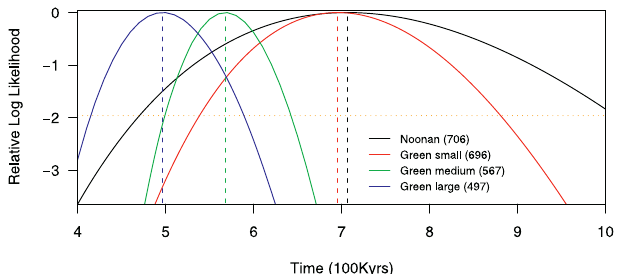
Figure 2. Relative Likelihood Curve for the Human–Neanderthal Divergence Time The Green et al. [2] data are divided into short ( (cid:2) 50 bp), medium ( . 50 and (cid:2) 100 bp), and large ( . 100 bp) fragments.